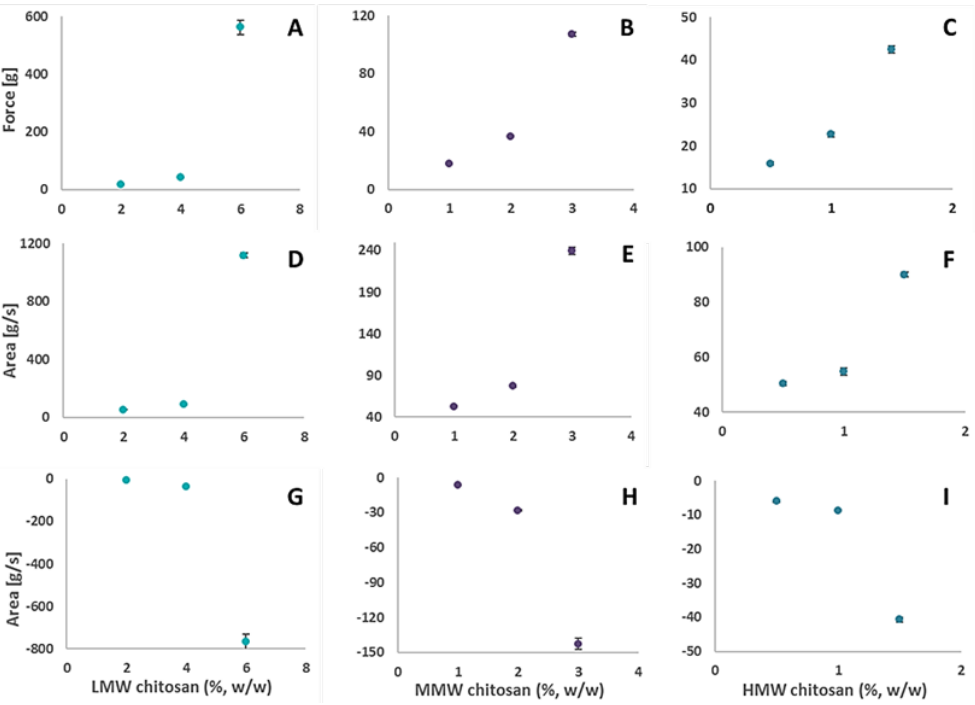
Figure 2. Texture analysis determining the hydrogel hardness ( A – C ), cohesiveness ( D – F ) and adhesiveness ( G – I ) for low molecular weight (LMW), medium molecular weight (MMW) and high molecular weight (HMW) chitosan hydrogels (%, w / w ).